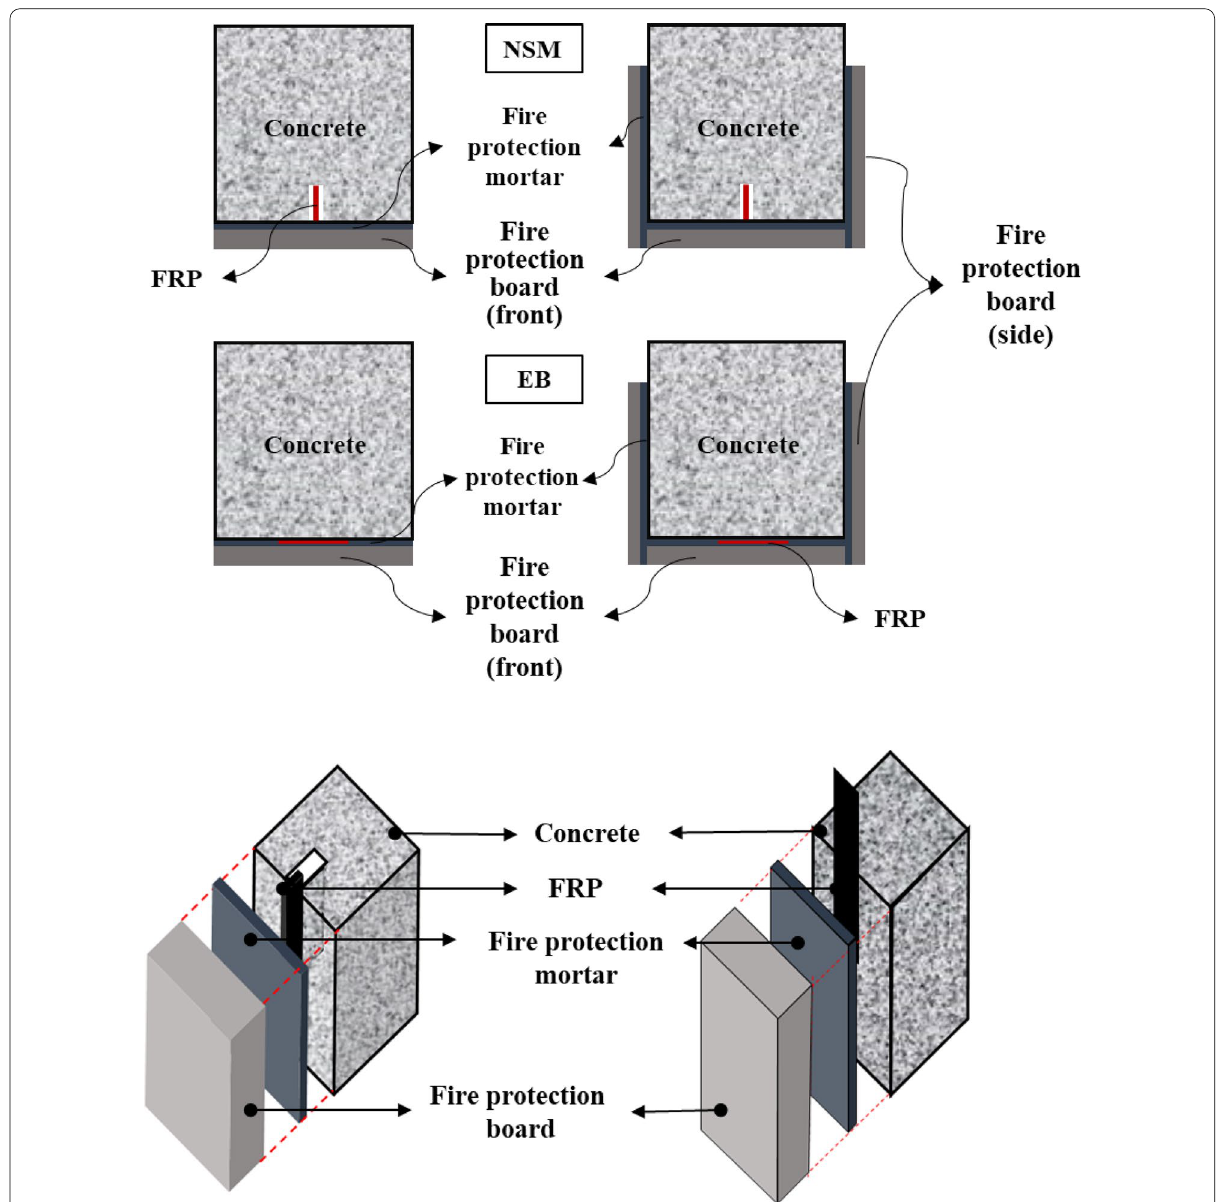
Fig. 1 Shape of specimens and concept of fire